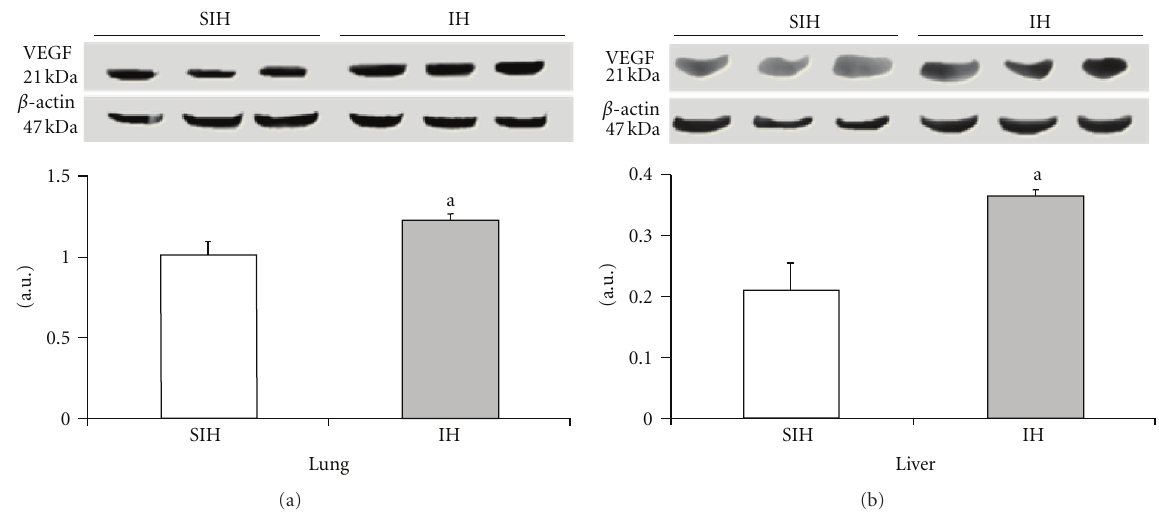
Figure 5: The e ff ect of intermittent hypoxia on the expression of VEGF in the liver ((a), P = 0 . 0062) and lung ((b), P = 0 . 0184). Results are reported as mean ± standard error, n = 6 per group. P value according to Student’s t